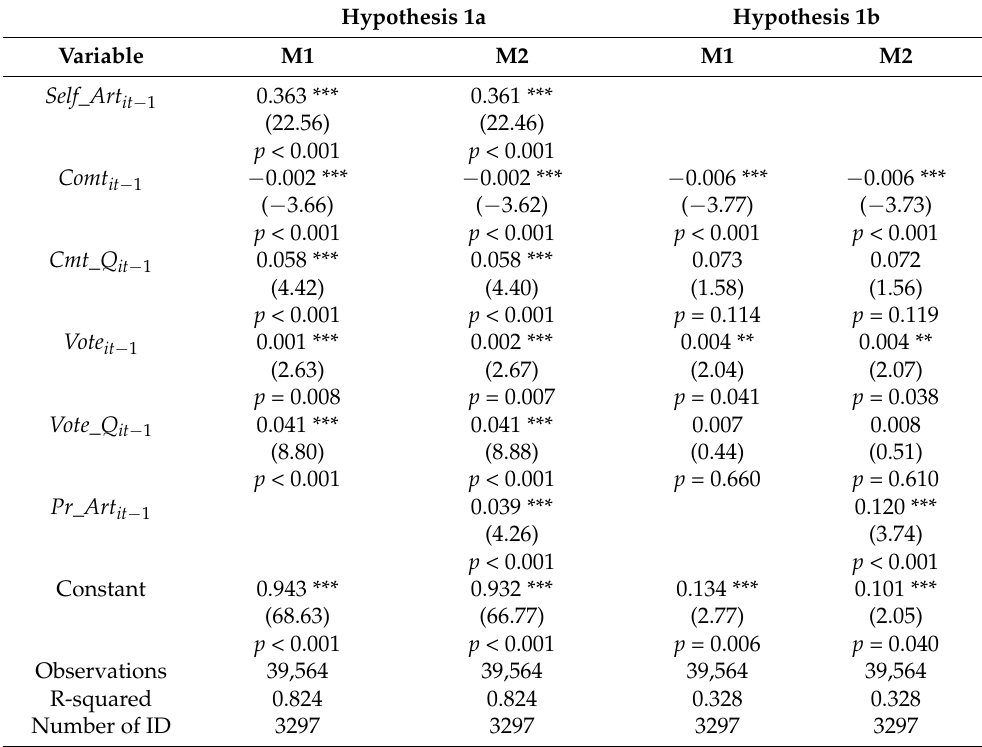
Table 2. Two-way fixed effect of Hypothesis 1.